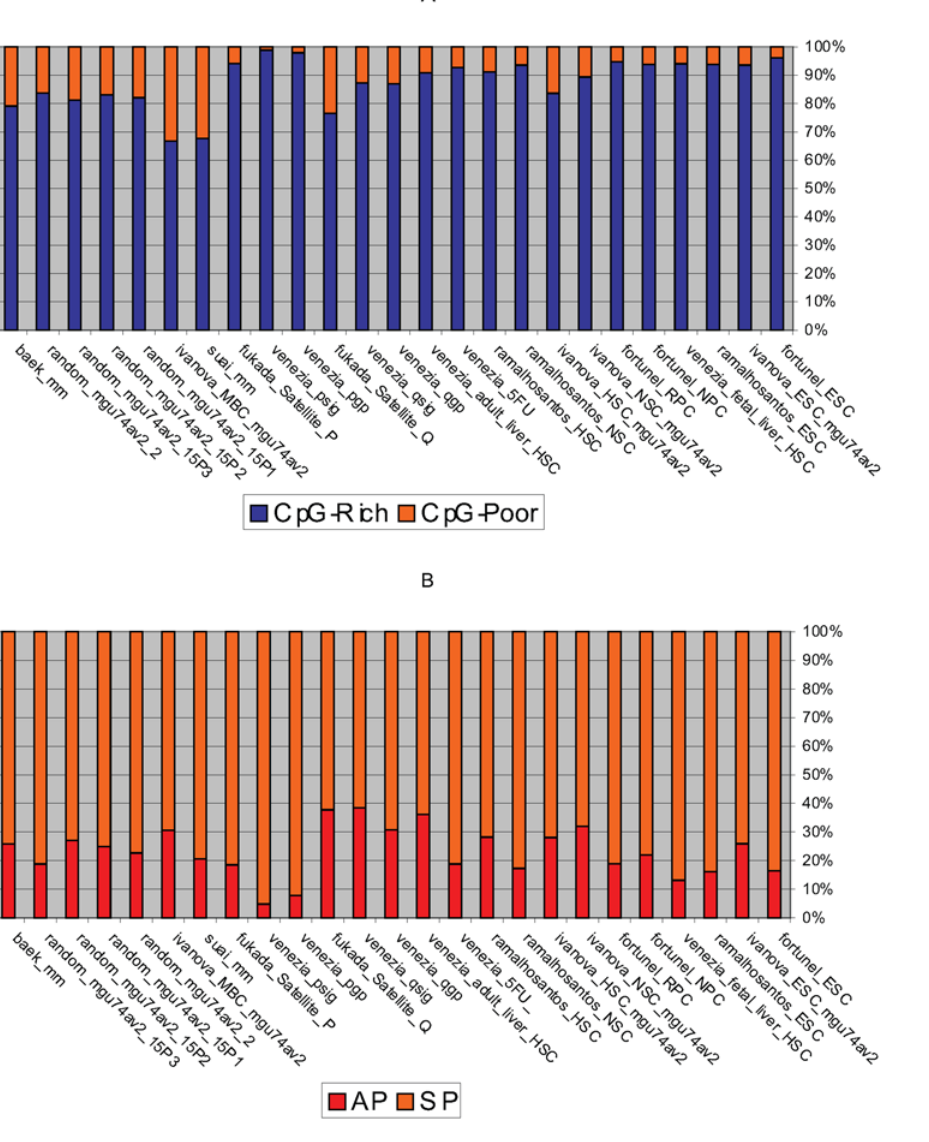
Figure 3. The percentage of the genes classed according to the promoter type. The promoters are characterised based on the Baek et al 2007 scheme. Consideration is given to ( A ) the genes using CpG-rich and CpG-poor promoters and ( B ) the genes with single and alternative promoters. doi:10.1371/journal.pone.0002712.g003 PLoS ONE |